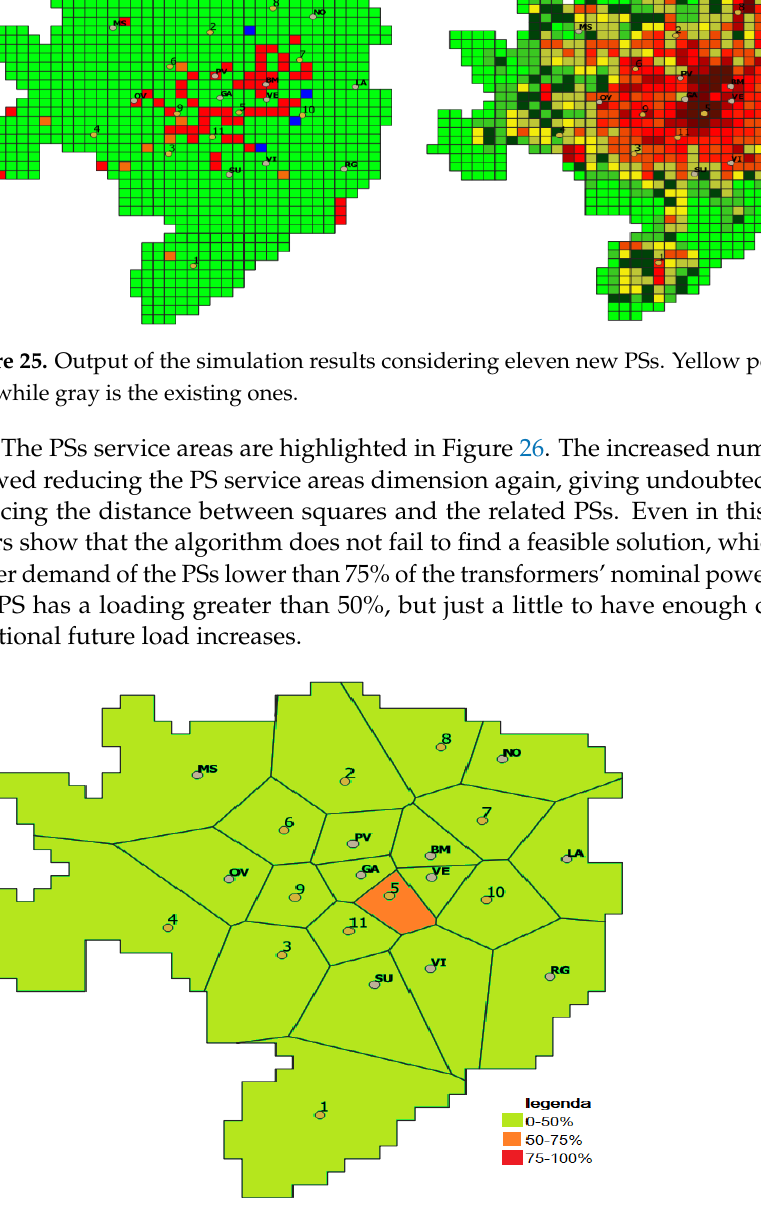
21 of 26 Figure 24. Best fitness through iterations and the global best fitness: eight additional PSs. Finally, the position of the new PS is compared with the areas already investigated by Unareti for the location of the PSs included in the developing plan and the existing MV substations. The new PS called “ 3 ” is not far away from the MV substation “ SV ” , while the new PS called “ 6 ” is not far away from the MV substation “ CR ” . Thus the methodology proposes to revamp them to take advantage of using the existing space. 4.3. Siting and Timing of Eleven PSs